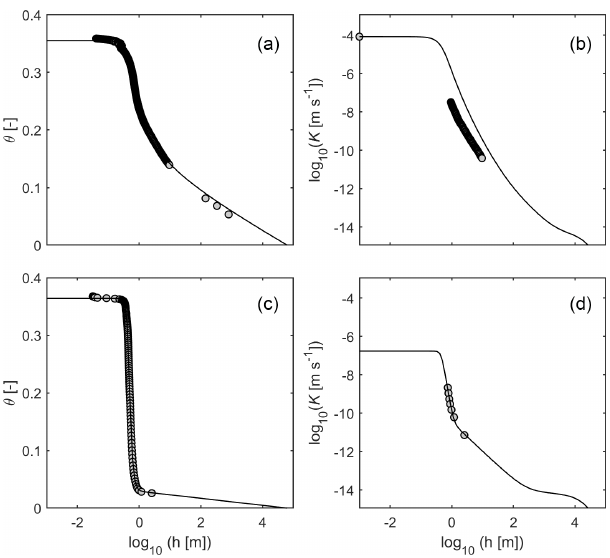
Figure 1. Example of conductivity predictions for two soils as ob- tained by scaling the capillary conductivity with measured conduc- tivity data. Plots on the left side show fitted retention functions; plots on the right side show the corresponding predicted conduc- tivity functions. (a, b) K prediction by matching the relative K function to the saturated conductivity, K s . (c, d) K prediction by matching the relative K function to unsaturated conductivity data, obtained using the simplified evaporation method. The retention functions and corresponding predicted hydraulic conductivity func- tions were parameterized using the Peters–Durner–Iden model sys- tem with the basic van Genuchten saturation function (Peters et al., 2021), as described in Appendix A. Data source: Peters et al.